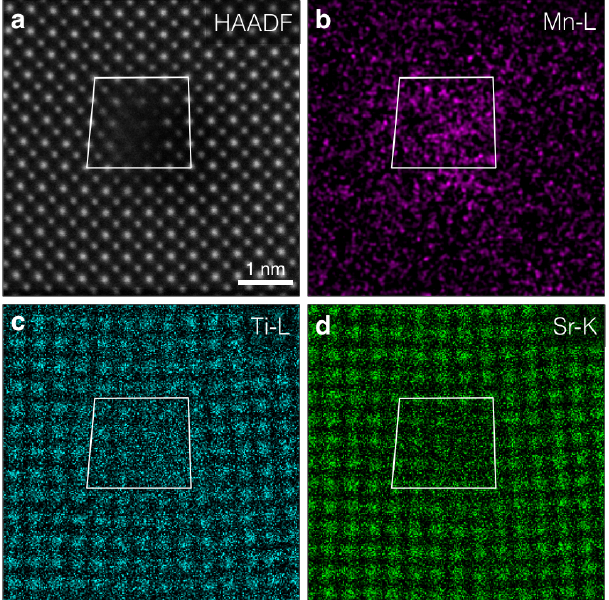
Figure 21. ( a ) HAADF STEM image and EDS elemental maps of ( b ) Mn; ( c ) Ti; and ( d ) Sr obtained from the dislocation core formed at the low-angle tilt grain boundary of SrTiO 3 .